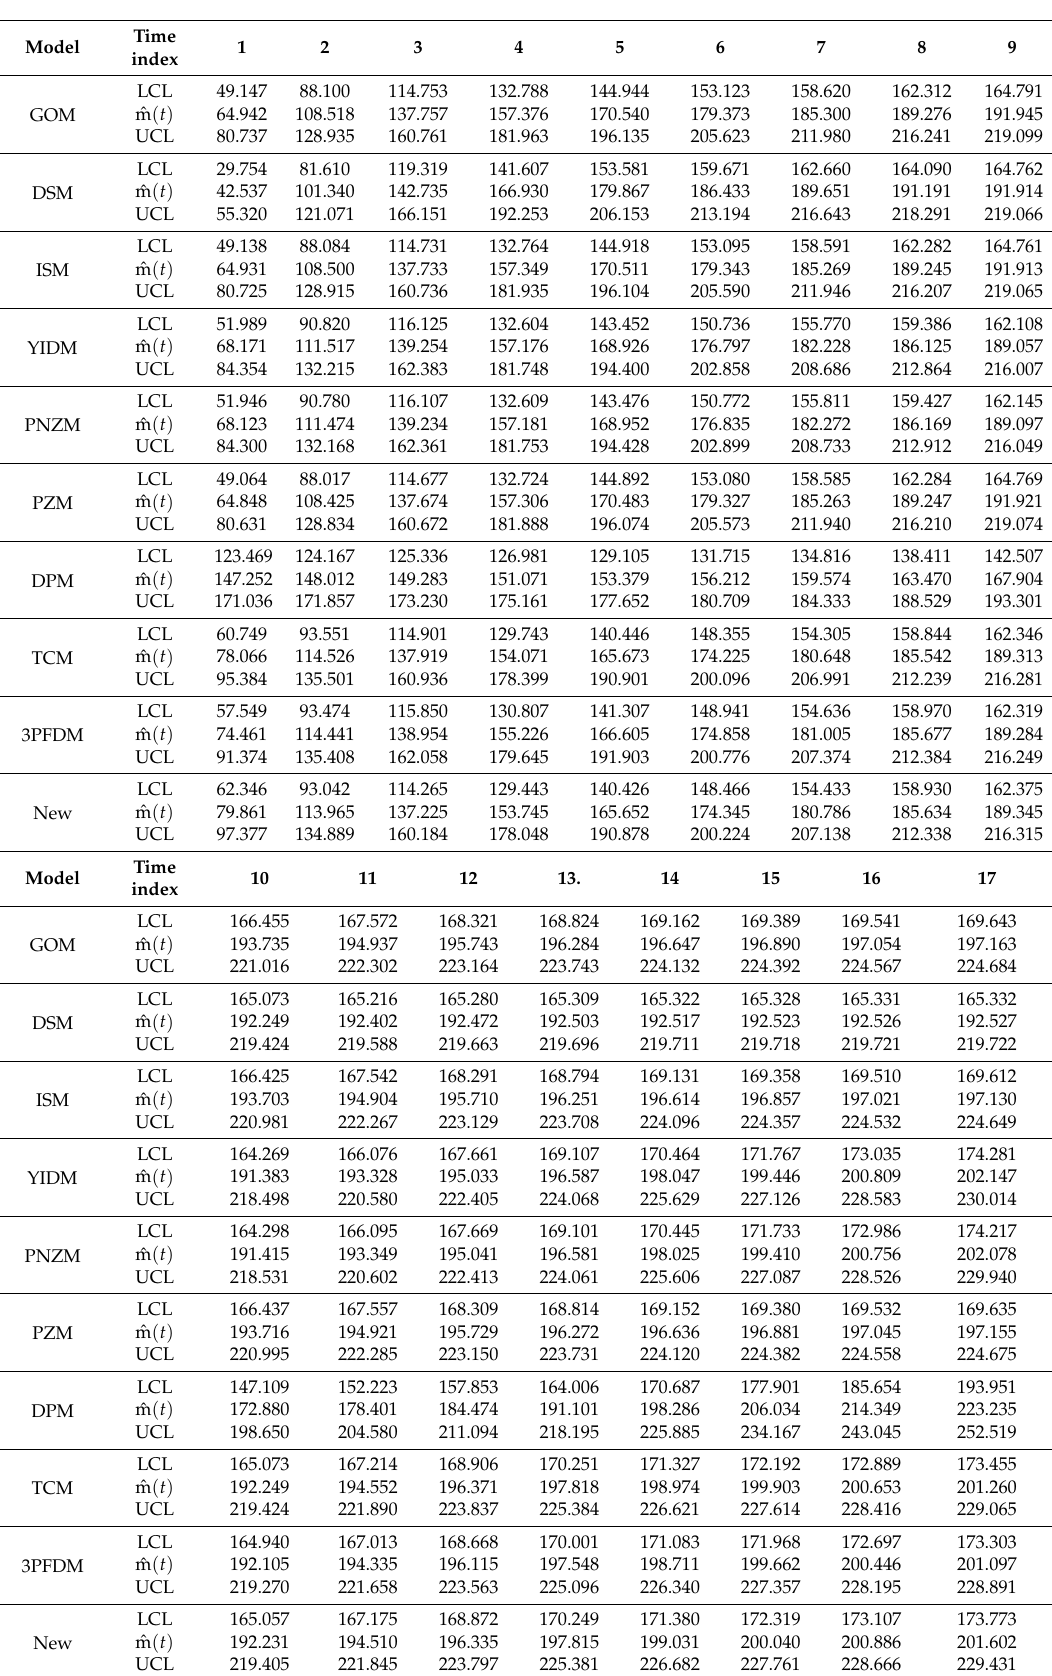
Table A2. 95% Confidence interval of all 10 models